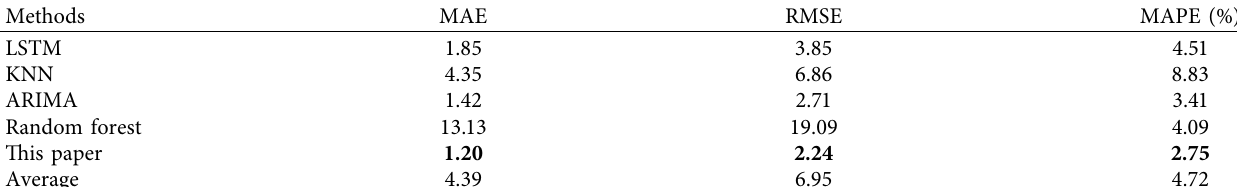
Table 6: Compare evaluation indicators with diferent models using speed data.